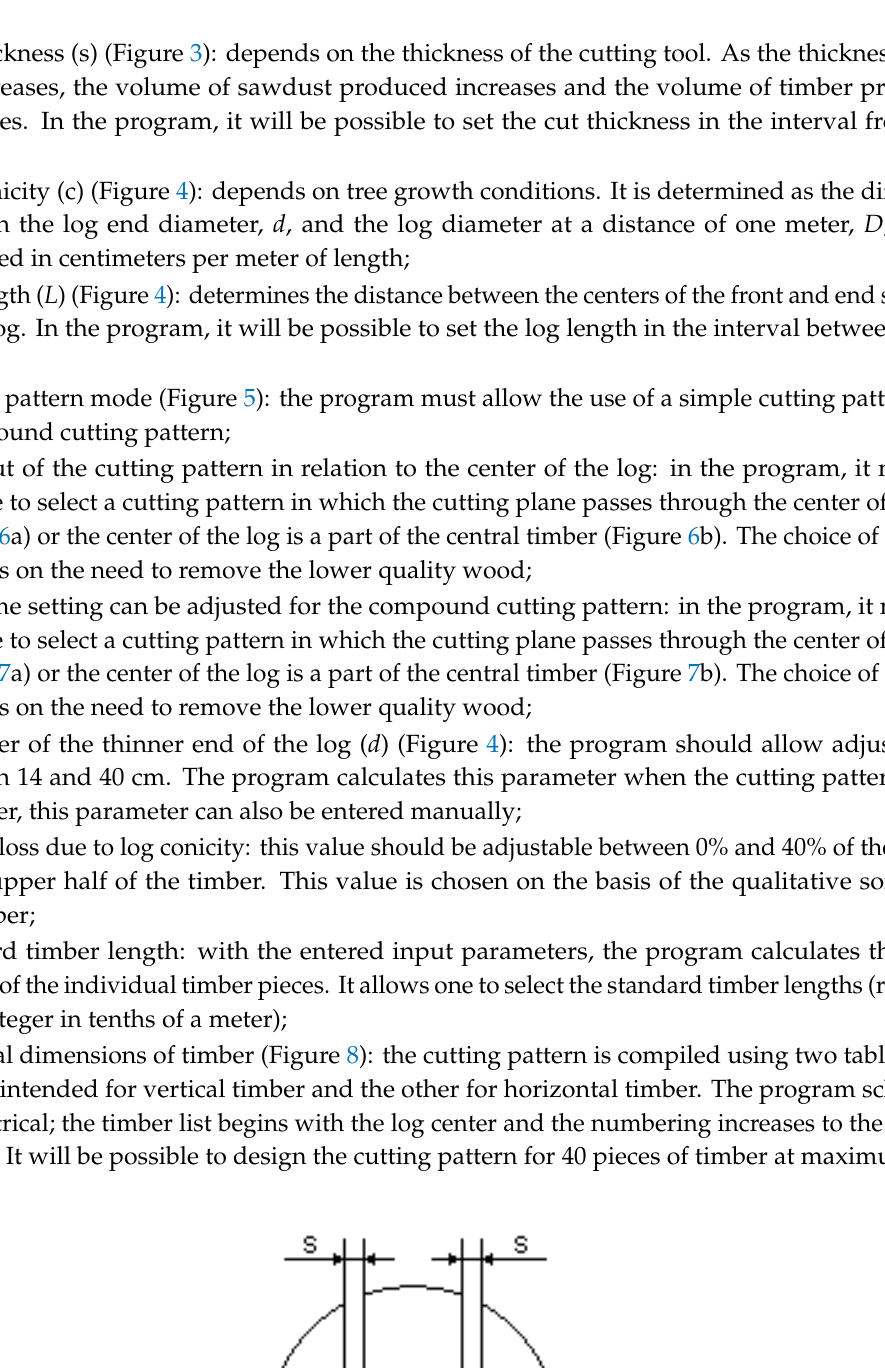
Figure 4. Log conicity. • compound Figure 5. Cutting pattern mode. •